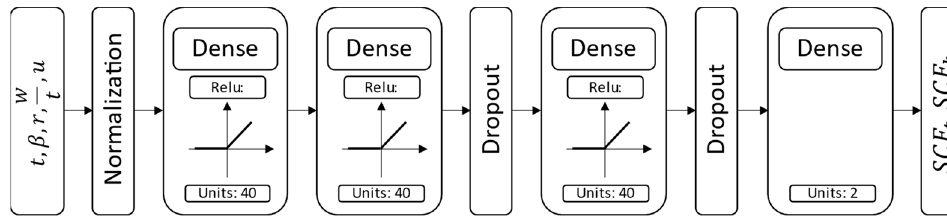
Figure 5. Visualization of the DNN.